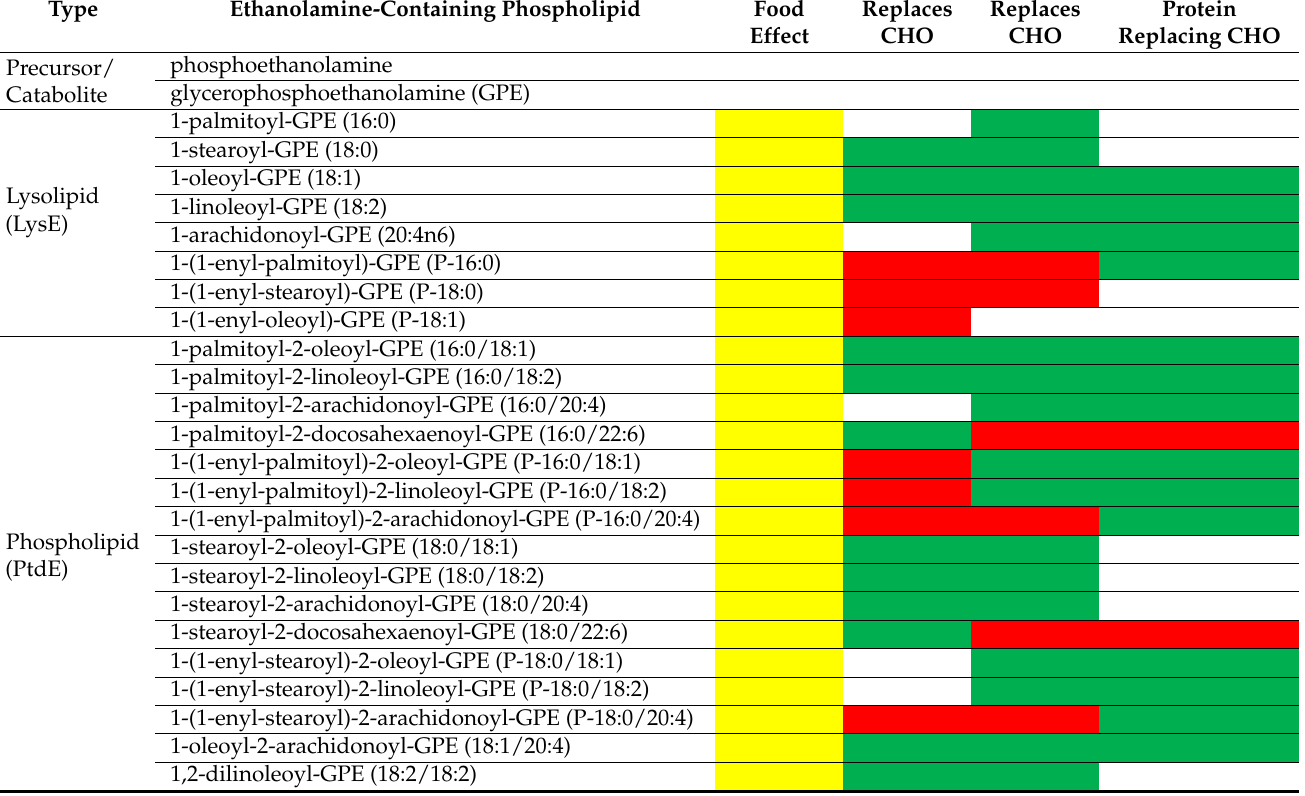
Table 12. Effects of foods on serum ethanolamine-containing